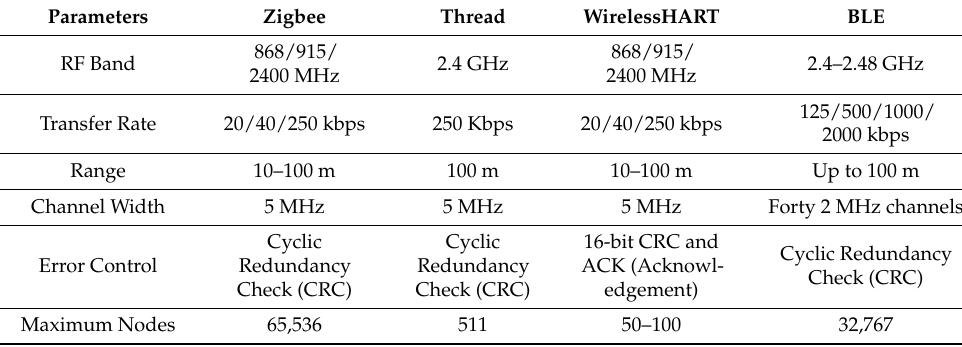
Table 2. Parameters of Low-Rate Network